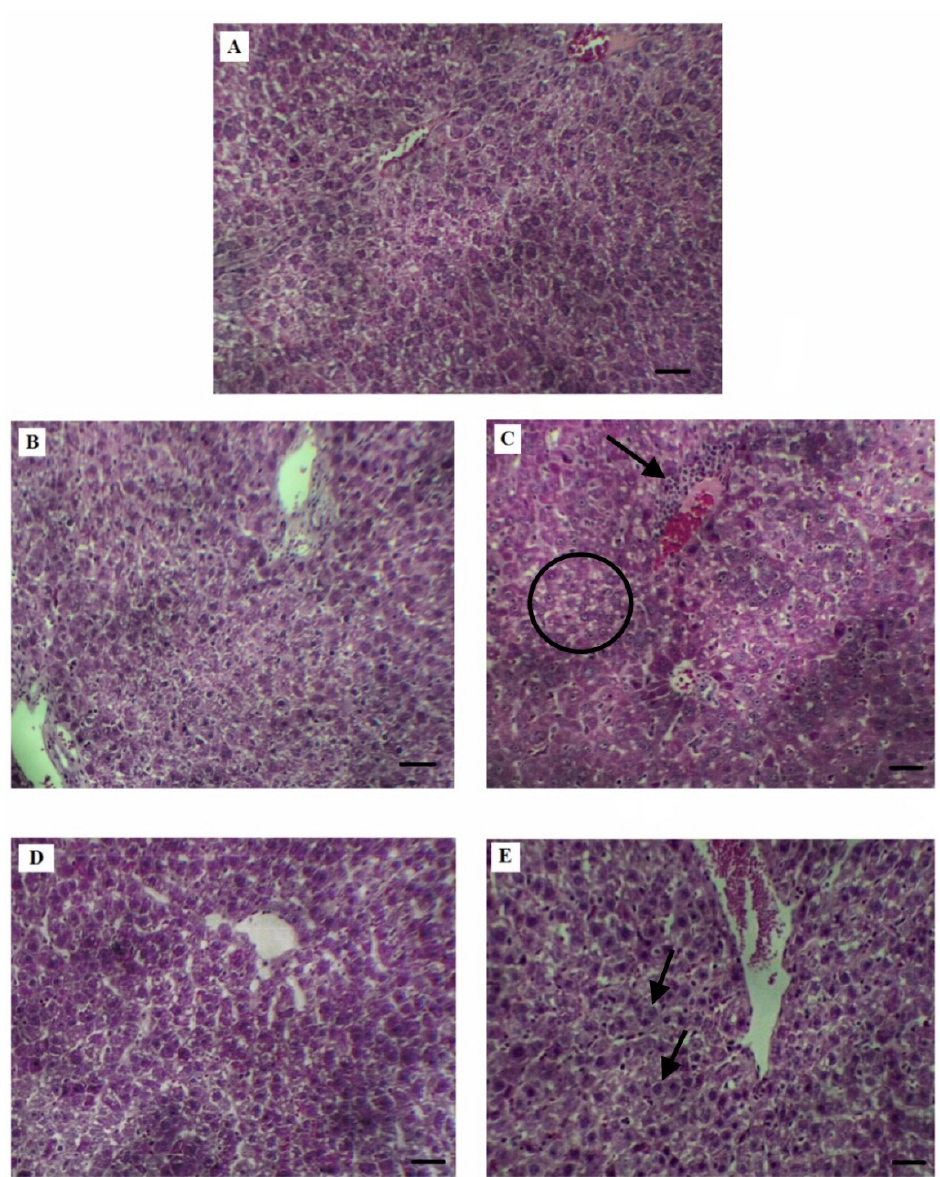
Figure 1. Histological profiles of liver cells. ( A ) Depicts the control group in which the liver histology is normal; ( B ) moderate congestion in group PH; ( C ) PH-EtOH, microvesicular steatosis (circle), inflammation (arrow), apoptosis, necrosis, and congestion; ( D ) moderate congestion in PH with SP group; ( E ) PH-EtOH-SP, decrease in apoptosis, necrosis and microvesicular steatosis, mitotic images (arrow). ( A – E ): bar = 15 µm.